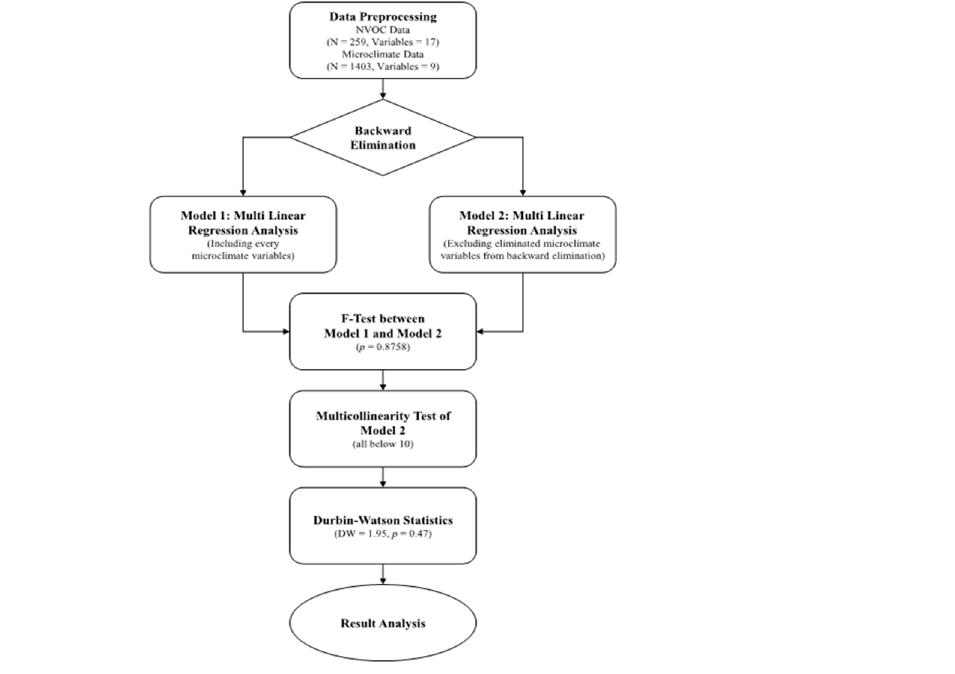
Figure 2. Flow diagram of regression analysis process. DW is the Durbin-Watson test statistic value.